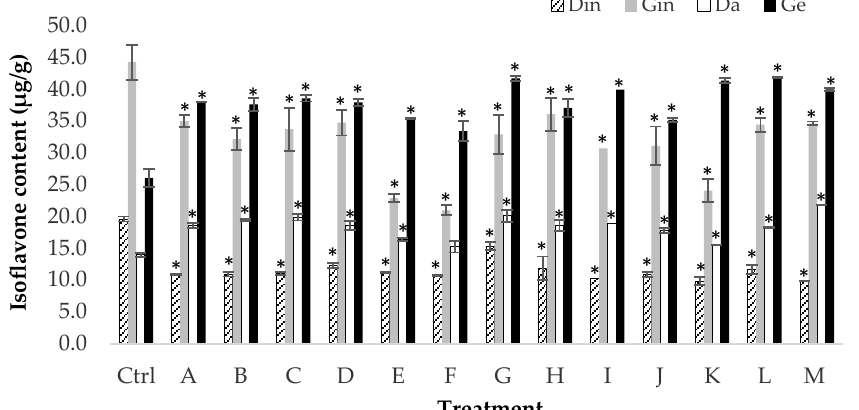
Figure 3. Individual isoflavone content ( µ g/g) of soymilk prepared from PEF-SBS. * Indicates significant difference ( p < 0.05) between soymilk obtained by PEF-SBS at specific conditions and control soymilk. Ctrl : Soymilk obtained from conventional extraction process. A : E = 2 kV/cm, n = 10; B : E = 10 kV/cm, n = 10; C : E = 2 kV/cm, n = 100; D : E = 10 kV/cm, n = 100; E : E = 2 kV/cm, n = 55; F : E = 10 kV/cm, n = 55; G : E = 6 kV/cm, n = 10; H : E = 6 kV/cm, n = 100; I – M : E = 6 kV/cm, n = 55.